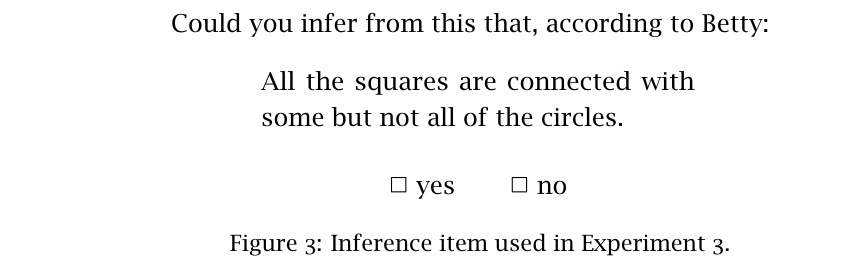
Figure 3 : Inference item used in Experiment 3